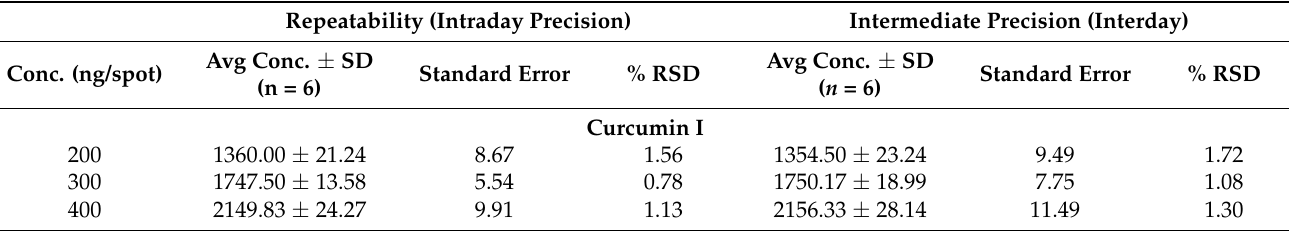
Table 3. Precision of the proposed method of curcumins